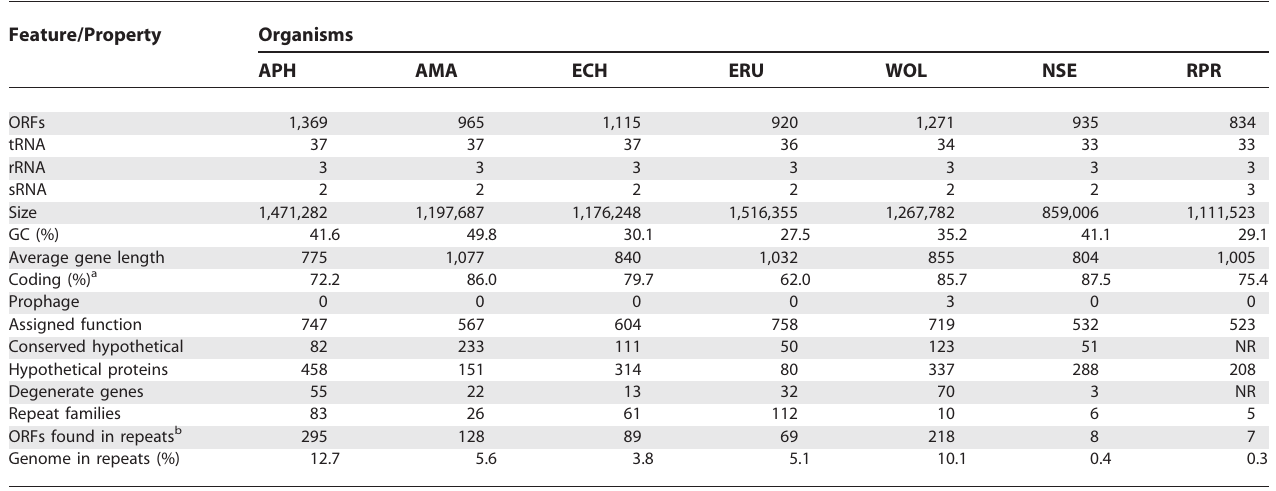
Table 2. Genome Properties Feature/Property